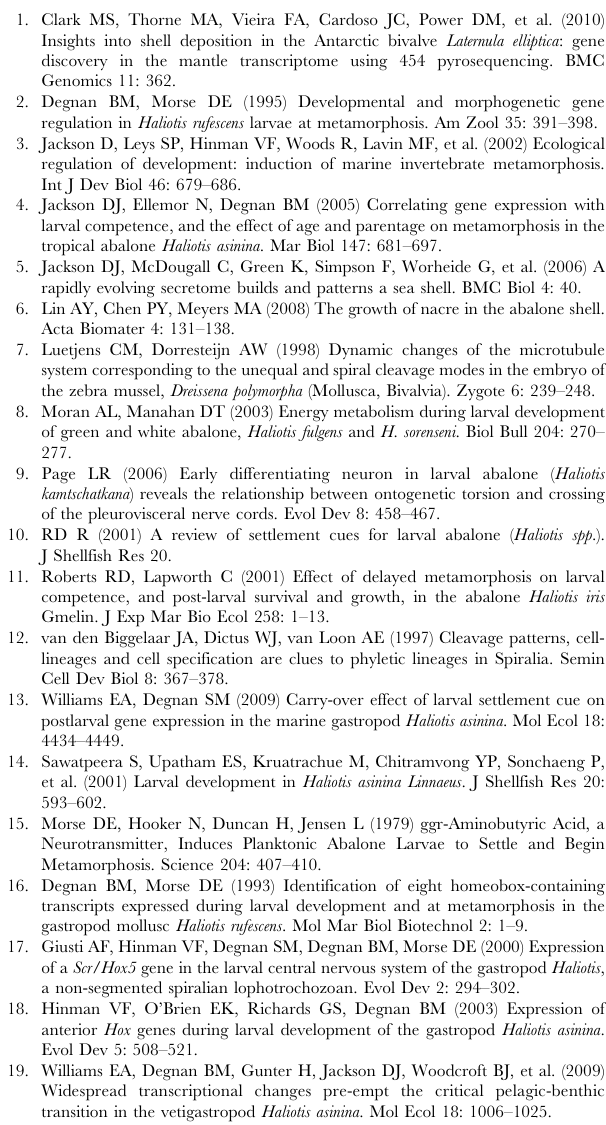
Table S3 Gene IDs in clusters A, B and C. (XLS) Text S1 Scaffolds and contigs/singletons with lengths shorter than 200